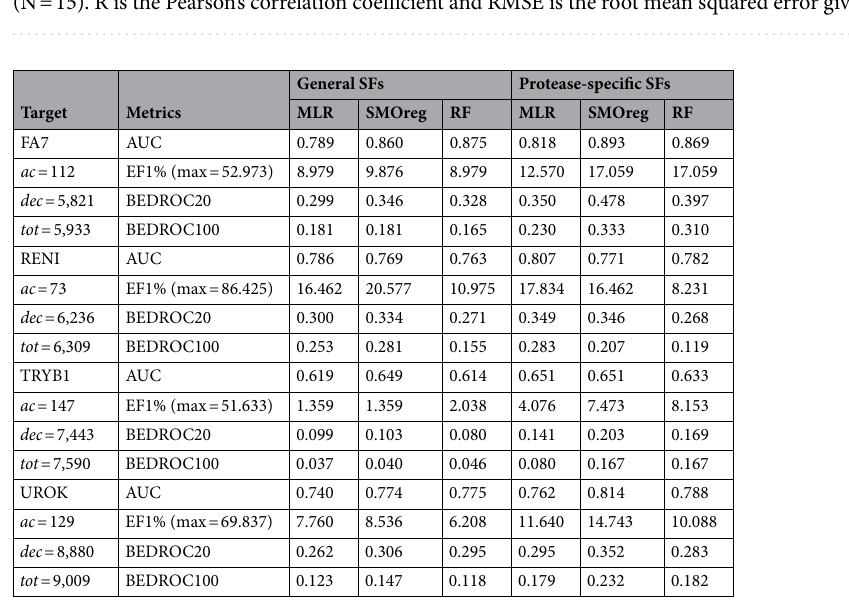
Table 5. Screening success of the general and target-specific scoring functions trained with MLR, SMOreg and RF for the FA7, RENI, TRYB1 and UROK datasets from DUD-E. ac , dec and tot are the number of active, decoy compounds and the total number of molecules in the final dataset (i.e., compounds that were docked and rescored with DockThor and DockTScore, respectively). Only the top-scored protonation state of a compound according to each scoring function (SF) was